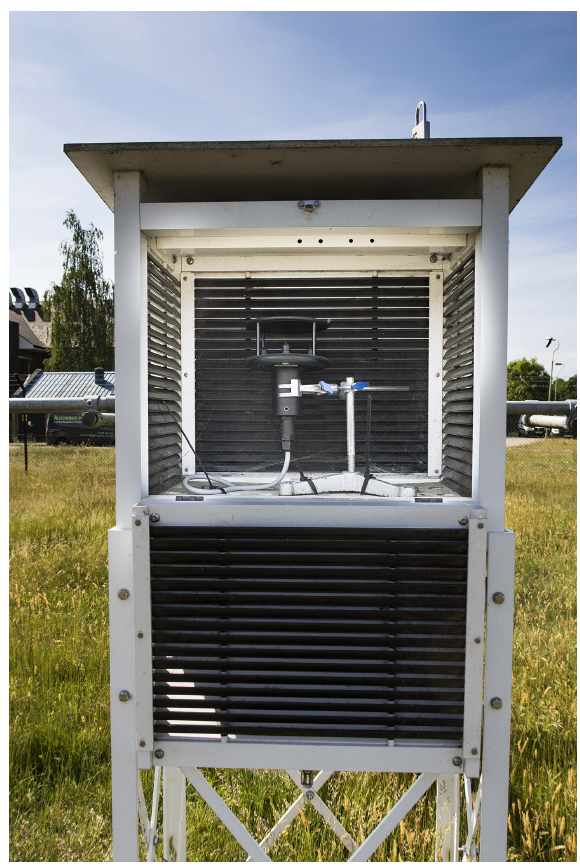
Figure 2. The Gill WindSonic anemometer located within the Stevenson screen shown in Fig. 1. The inside dimensions of the screen were 50cm width × 25cm depth × 43cm height. This photograph was taken on 27 May 2020. Photograph © Stephen